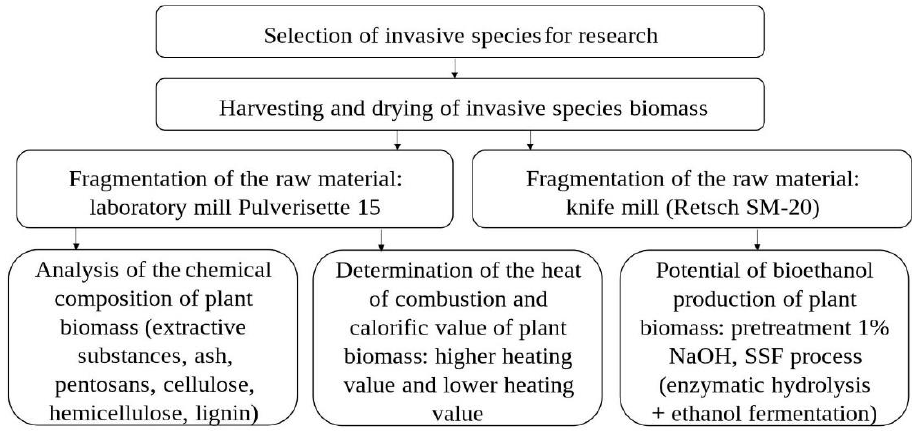
Figure 1. The general block diagram showing the work steps.